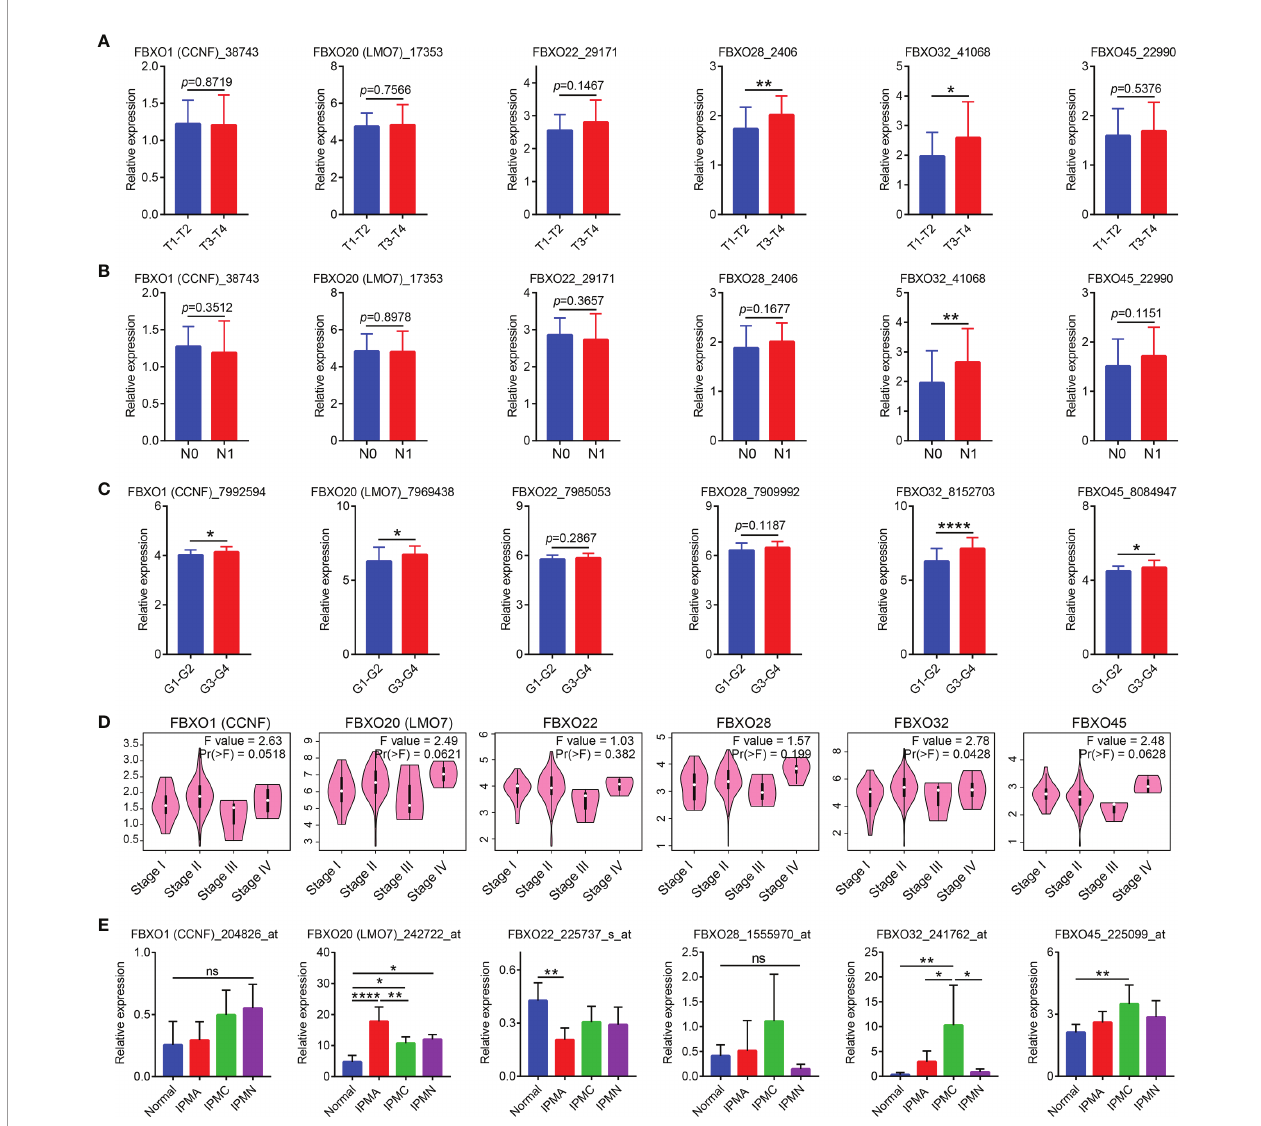
FIGURE 3 | Correlation between six-FBXO expression and the clinicopathological characteristics of pancreatic ductal adenocarcinoma (PDAC) patients in GEO datasets and GEPIA. (A) The expression levels of six-FBXOs via the comparison between T1 – T2 ( n = 18) and T3 – T4 ( n = 80) in GSE21501 dataset. (B) The expression levels of six-FBXOs in PDAC patients with/without lymphatic metastasis (N1/N0, 73 vs . 28) in GSE21501 dataset. (C) The mRNA levels of six-FBXOs in different differentiation degrees of PDAC (G1 – G2 vs . G3 – G4, 37 vs . 31) using GSE62452 dataset. (D) The expression levels of six-FBXOs in different pathological stages using GEPIA. (E) The transcriptional levels of six-FBXOs in different pancreatic precancerous lesions compared with normal pancreatic tissues using GSE19650 dataset. Normal ( n = 7), IPMA ( n = 6), IPMC ( n = 6), and IPMN ( n = 3). The code behind the gene is the probe name in different GEO datasets. * P < 0.05, ** P < 0.01 **** P < 0.0001. n.s., not signi fi cant